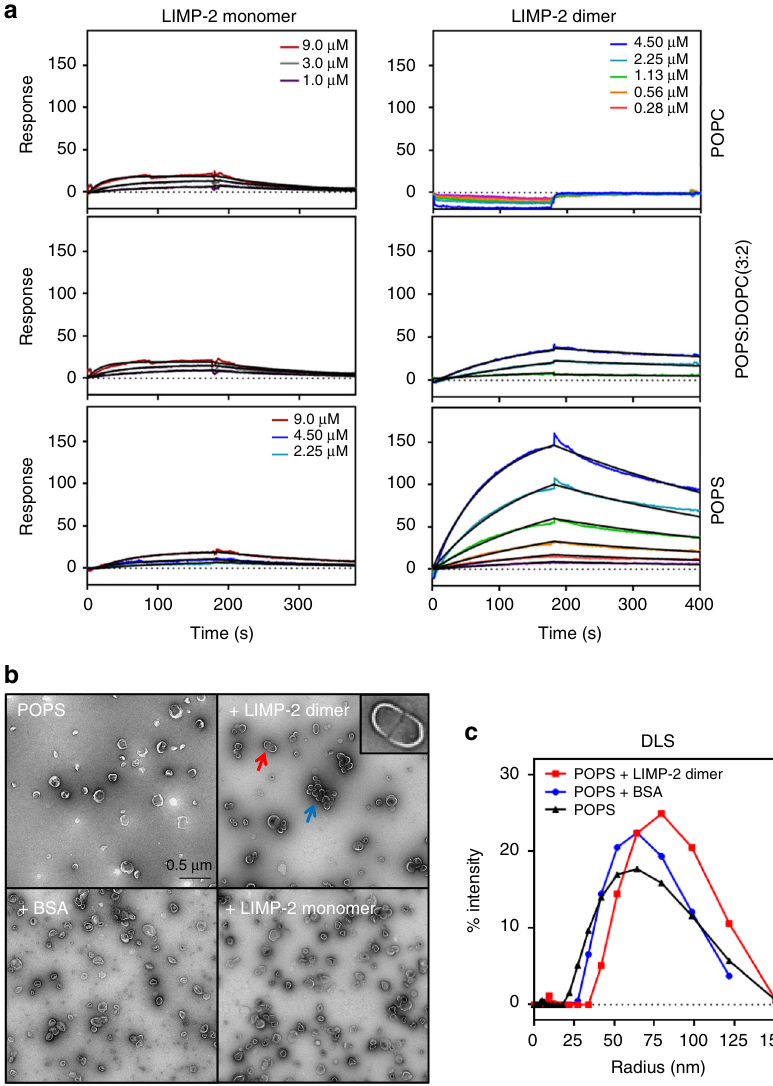
Fig. 3 LIMP-2 binding to liposomes characterized by SPR, NS-EM, and DLS. a Binding kinetics of LIMP-2 to liposomes at pH 7.5 were characterized by SPR. Representative SPR sensorgrams (colored traces) of LIMP-2 monomer (left) and dimer (right) binding to immobilized POPC (top panel), DOPS:DOPC (3:2) (middle) and POPS liposomes (bottom) at concentrations indicated were overlaid with kinetic fi tting curves (black) using 1:1 kinetic model. The binding responses are scaled according to dimer-POPS responses. Immobilized levels of POPC, DOPS:DOPC (3:2), and POPS on the L1 SPR chip were 8900, 7500, and 6000 units, respectively. b Examples of negative stain EM micrographs indicate the LIMP-2 dimer bridges POPS liposomes and induces clustering of liposomes. Red arrow indicates a clear example of two liposomes forming a tight association with a clear boundary bridged by LIMP-2 dimer (insert is enlarged view). Blue arrow indicates a grape bundle shaped cluster of multiple liposomes. These features are not observed in any images of BSA and LIMP- 2 monomer samples, which were used as negative controls. Total numbers of images observed were 5, 8, 16, and 12 for BSA + POPS, monomer + POPS, POPS, and POPS+ LIMP-2 dimer, from duplicated experiments. c Addition of LIMP-2 dimer into POPS liposome (red) shifts the DLS pro fi les of POPS liposome (black). POPS liposome with BSA (blue) used as a negative control. The average radii are 50.6 ± 0.4, 6.53 ± 0.06, 68.6 ± 1.1, 3.84 ± 0.02, 52.4 ± 4 Å for PS liposome, LIMP-2 dimer, PS + LIMP-2 dimer, BSA, and PS + BSA, respectively from 15 measurements of each duplicated experiments. The estimated molecular weights of POPS and POPS + LIMP-2 dimer are 32,774 ± 1300 and 66,557 ± 2500 KD,